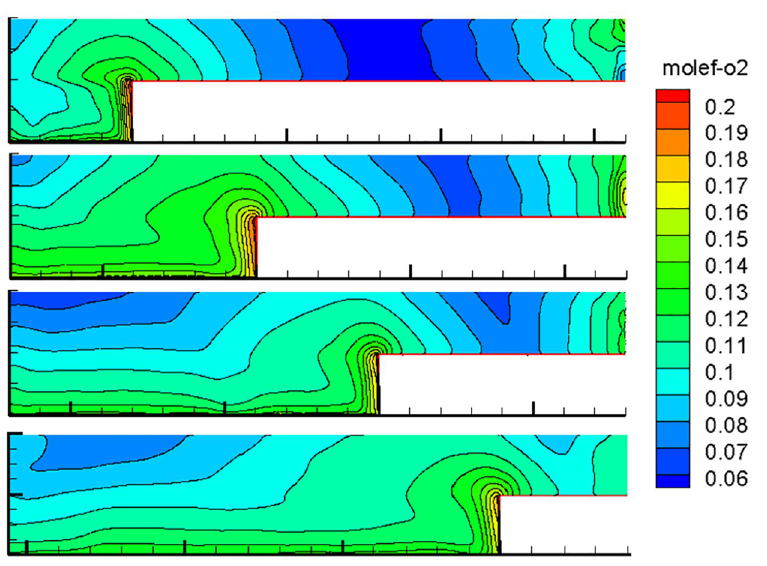
Fig 7. Flow field distribution of the oxygen volume fraction in the goaf at 0% air